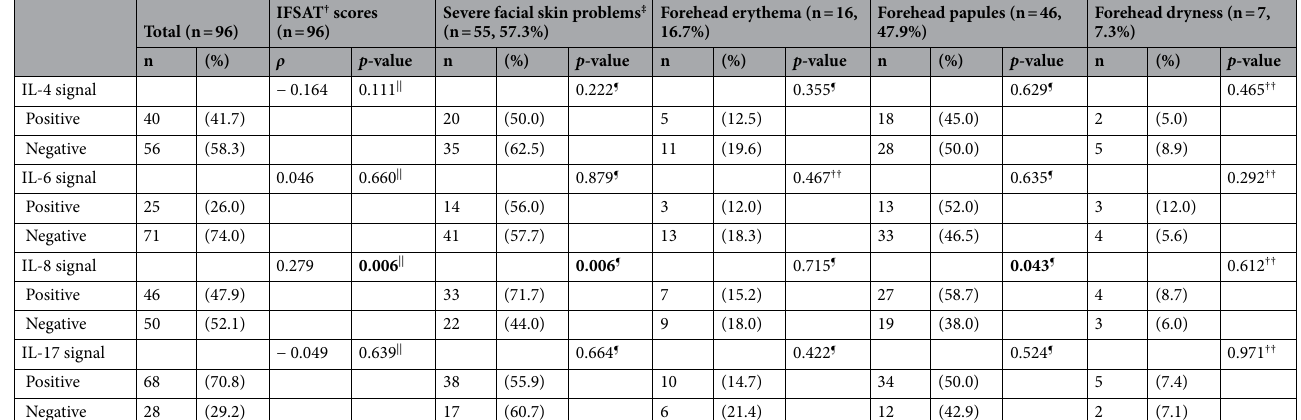
Table 2. Relationship of four inflammatory cytokine signals by skin blotting method with IFSAT scores, severe facial skin problems, forehead erythema, forehead papules, and forehead dryness (n = 96). Significant